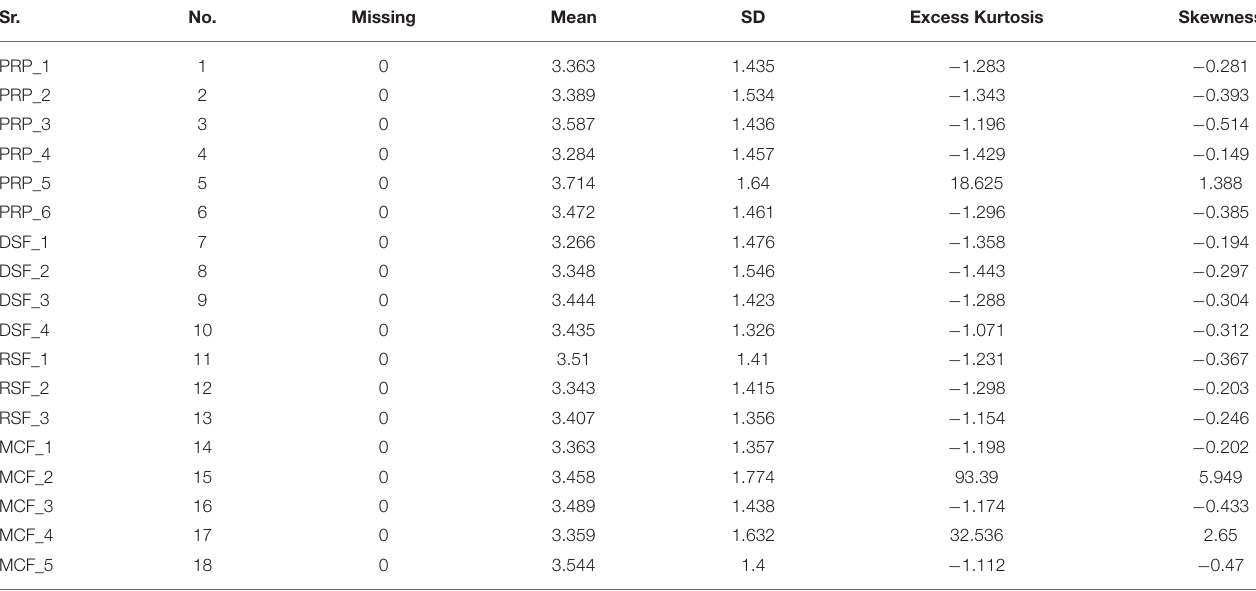
TABLE 5 | Mean scores, standard deviation scores, skewness, and excess kurtosis values. Sr.